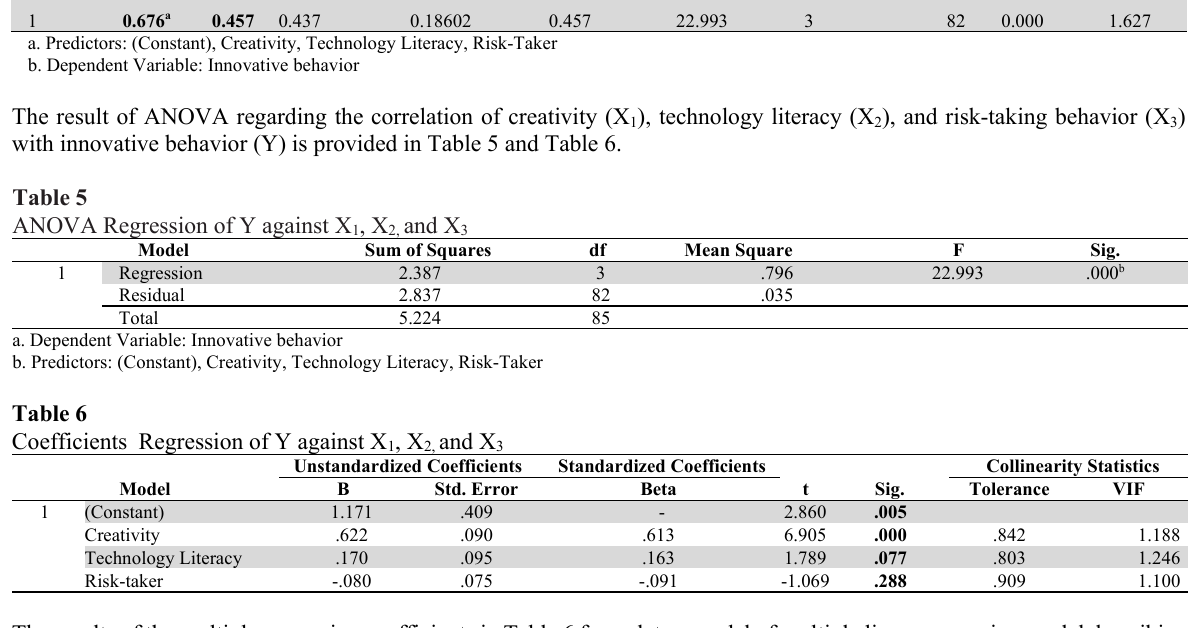
The results of the multiple regression coefficients in Table 6 formulate a model of multiple linear regression model describing the correlation of the innovative behavior (Y) with creativity (X 1 ), technology literacy (X 2 ), and risk-taking behavior (X 3 ) as shown